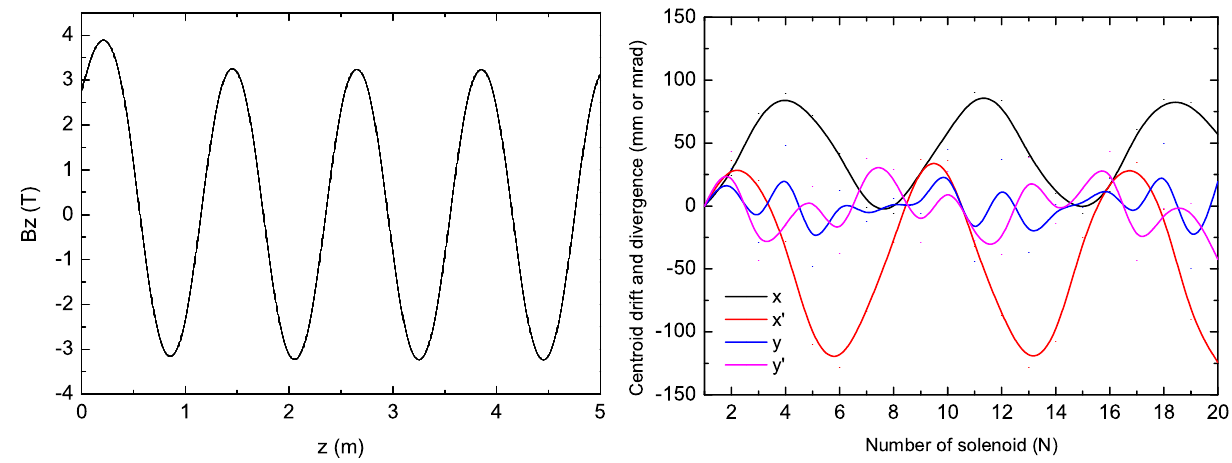
FIG. 15. Field distribution (left) and the beam centroid excursions (right) in a part of the bending